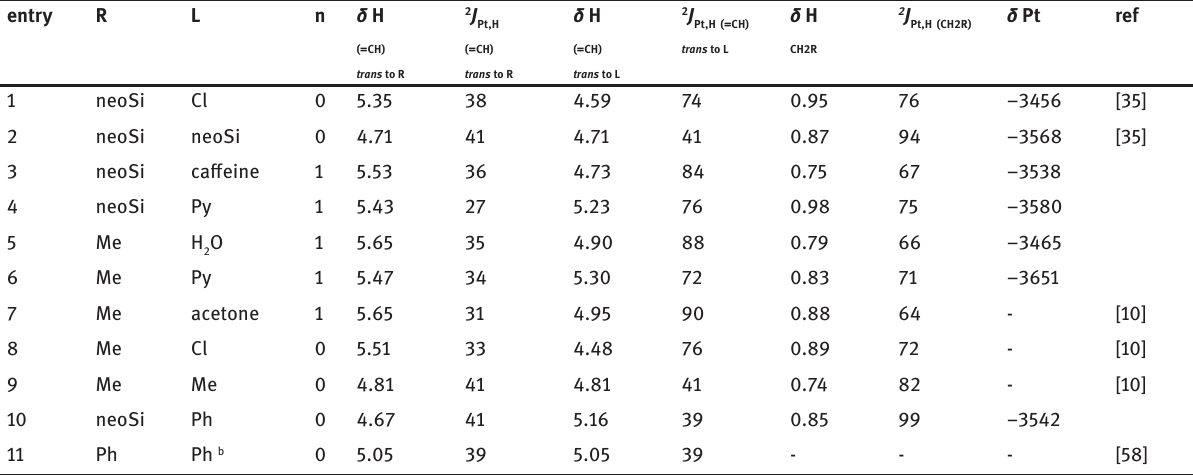
Table 1: Selected NMR data of [Pt(cod)(R)(L)] n+ complexes. a